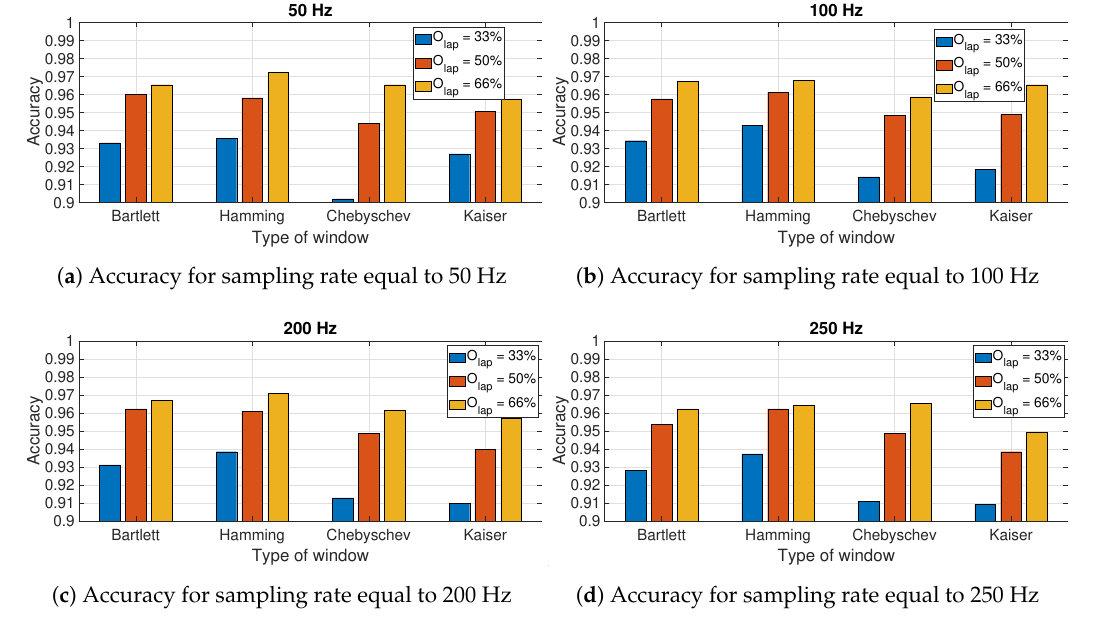
Figure 13. Accuracy for GyroY in relation to the type of window used in the spectrogram for different sample rates and different values of the overlapping factor O lap and W R =